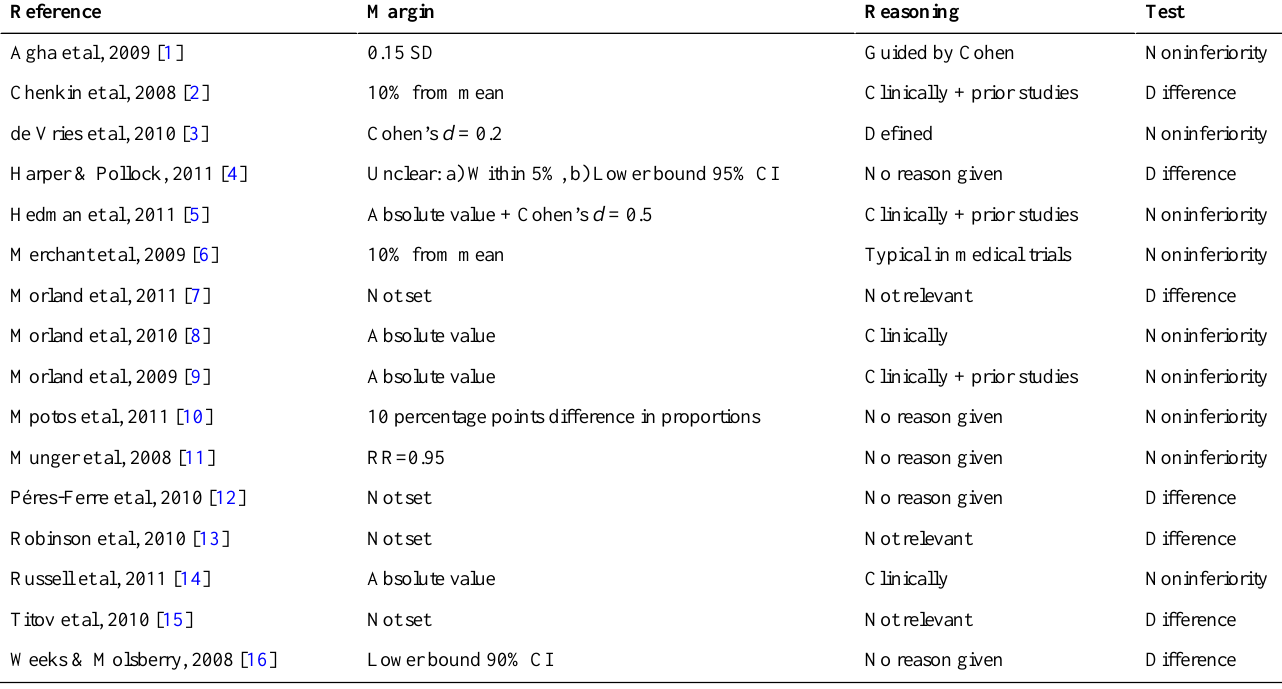
Table 2. Articles included in